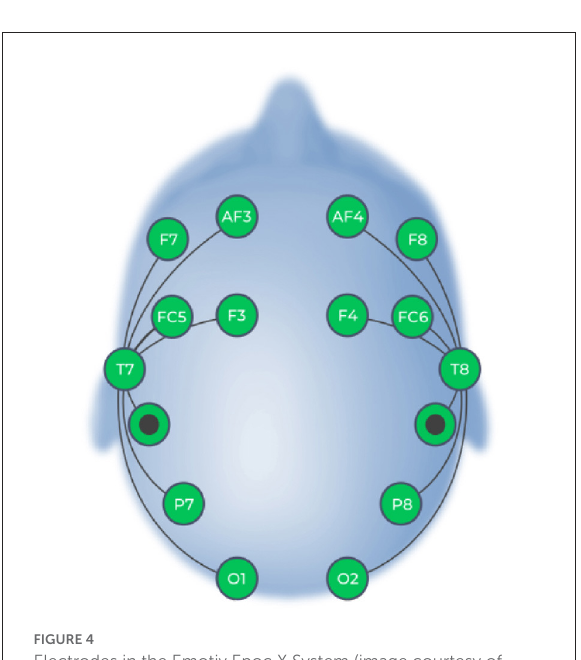
FIGURE4 Electrodes in the Emotiv Epoc X System (image courtesy of Emotiv).